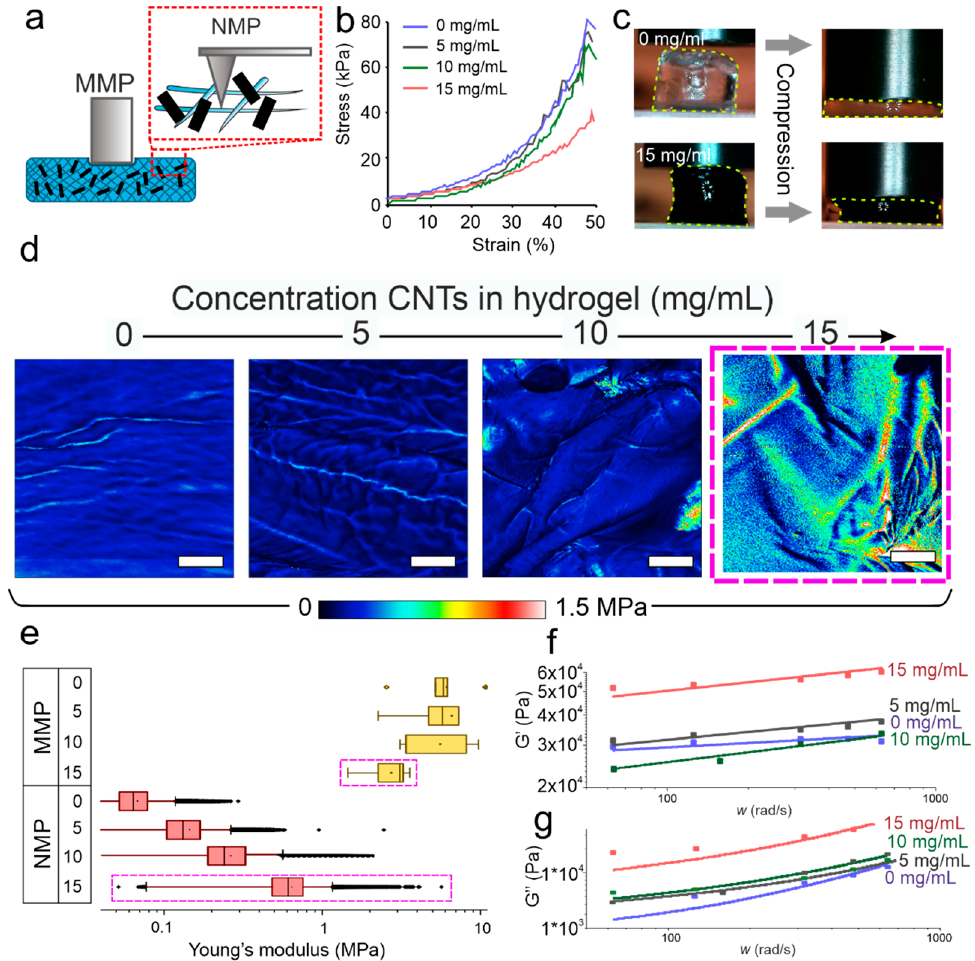
Figure 3. ( a ) Schematic representation of Macro Mechanical Properties (MMP) and Nano Mechanical Properties (NMP) measurements. ( b ) Stress/strain curves obtained by an Universal Testing Machine (UTM). ( c ) Images of the compression process of GG-CNTs hydrogels. ( d ) Force mapping of the surface of GG-CNTs hydrogels obtained by AFM. The scale bar is 5 μ m (the scale bar is 4 μ m). ( e ) The Young’s modulus values for GG-CNTs obtained using UTM (10 mm tip) and AFM. The relative standard error for AFM measurements is less than 1%. ( f ) The storage modulus of GG-CNTs hydrogels as a function of frequency. ( g ) The loss modulus of GG-CNTs hydrogels as a function of frequency.